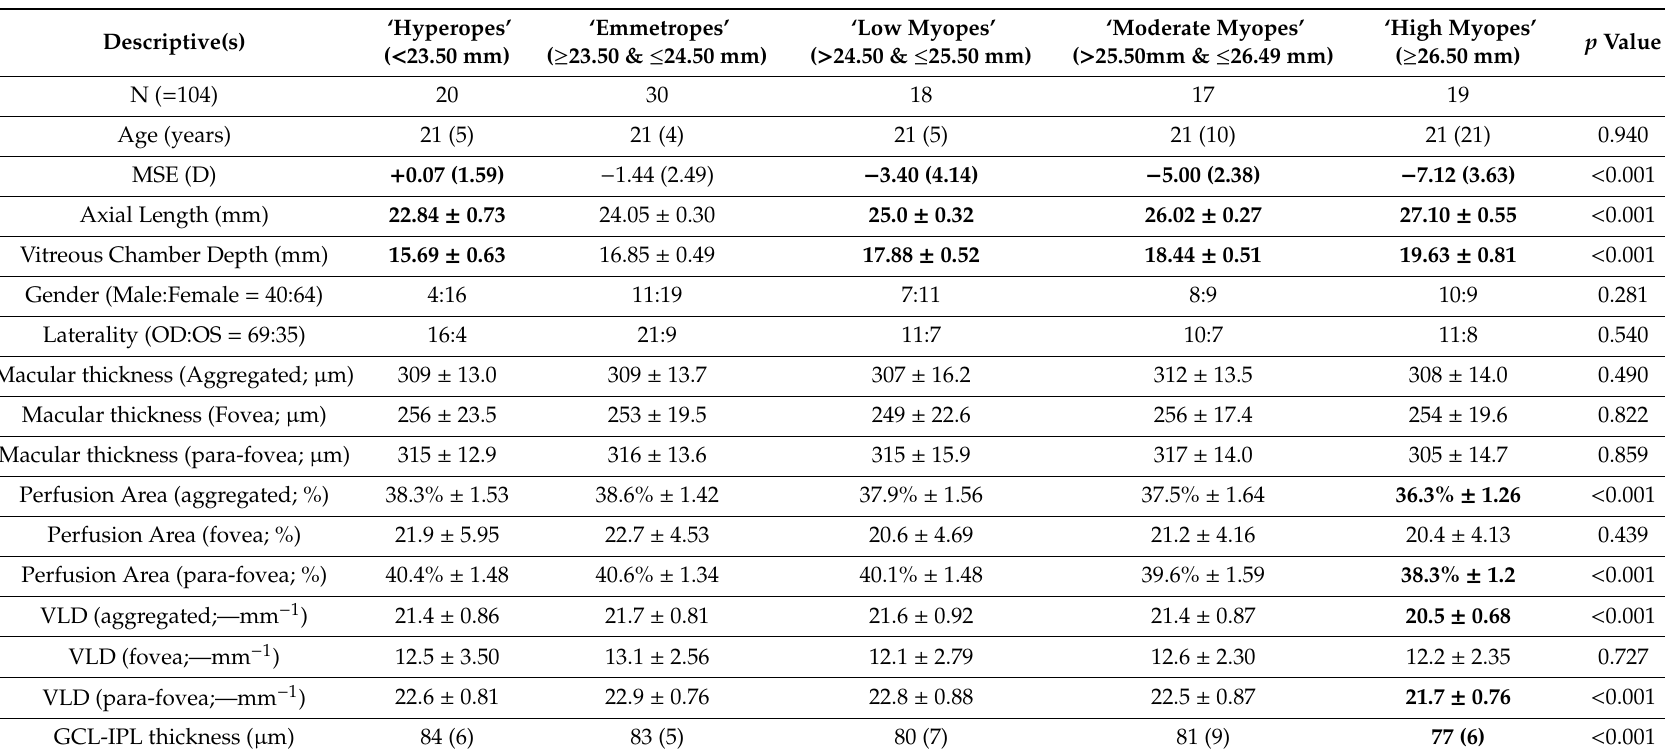
Table 1. Demographic characteristics and outcome measures of participants between the refractive